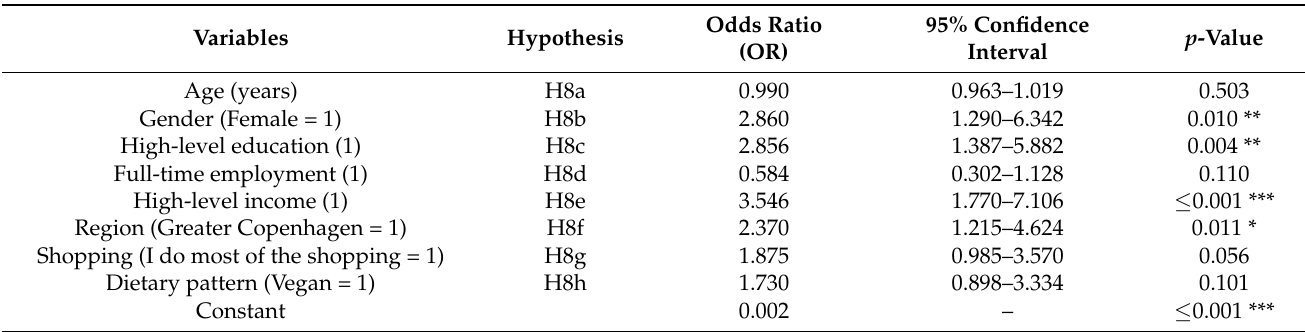
Table 2. Association between plant-based yogurt alternatives behaviour and socio-demographic characteristics and lifestyle determinants (N =